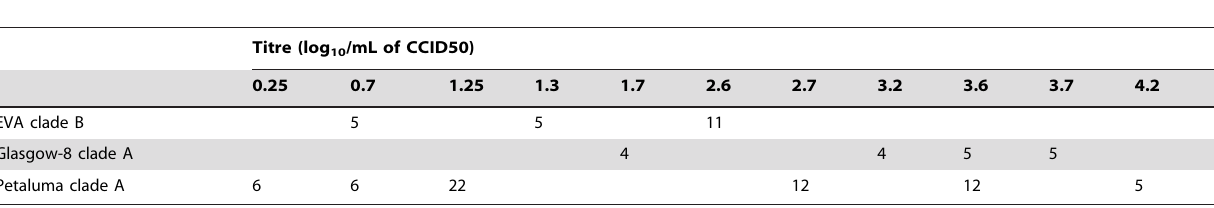
Table 1. Number of infected cats according to the virus strain and the inoculum